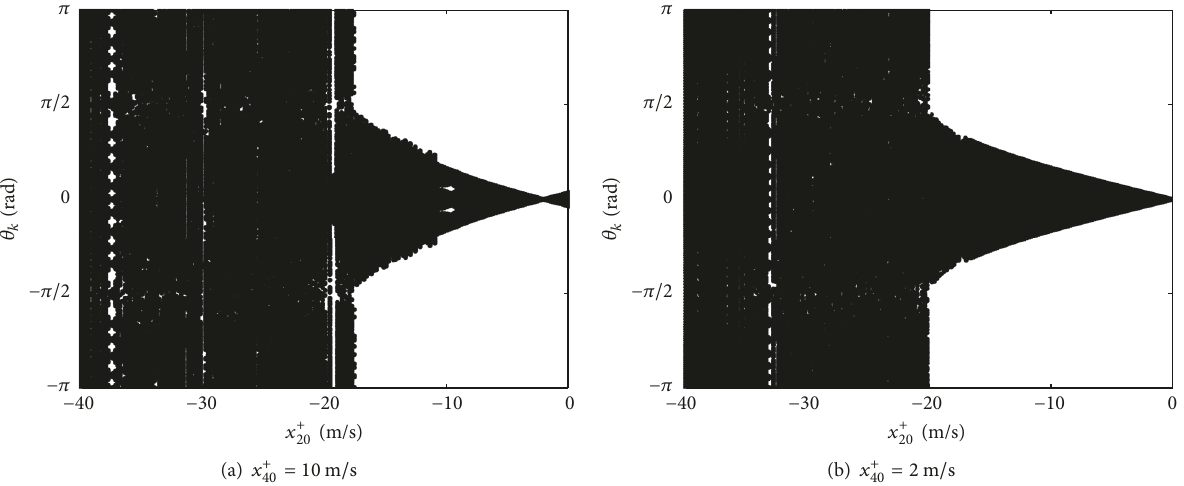
Figure 5: Bifurcations of pitch angle with increase of 𝑥 + 20